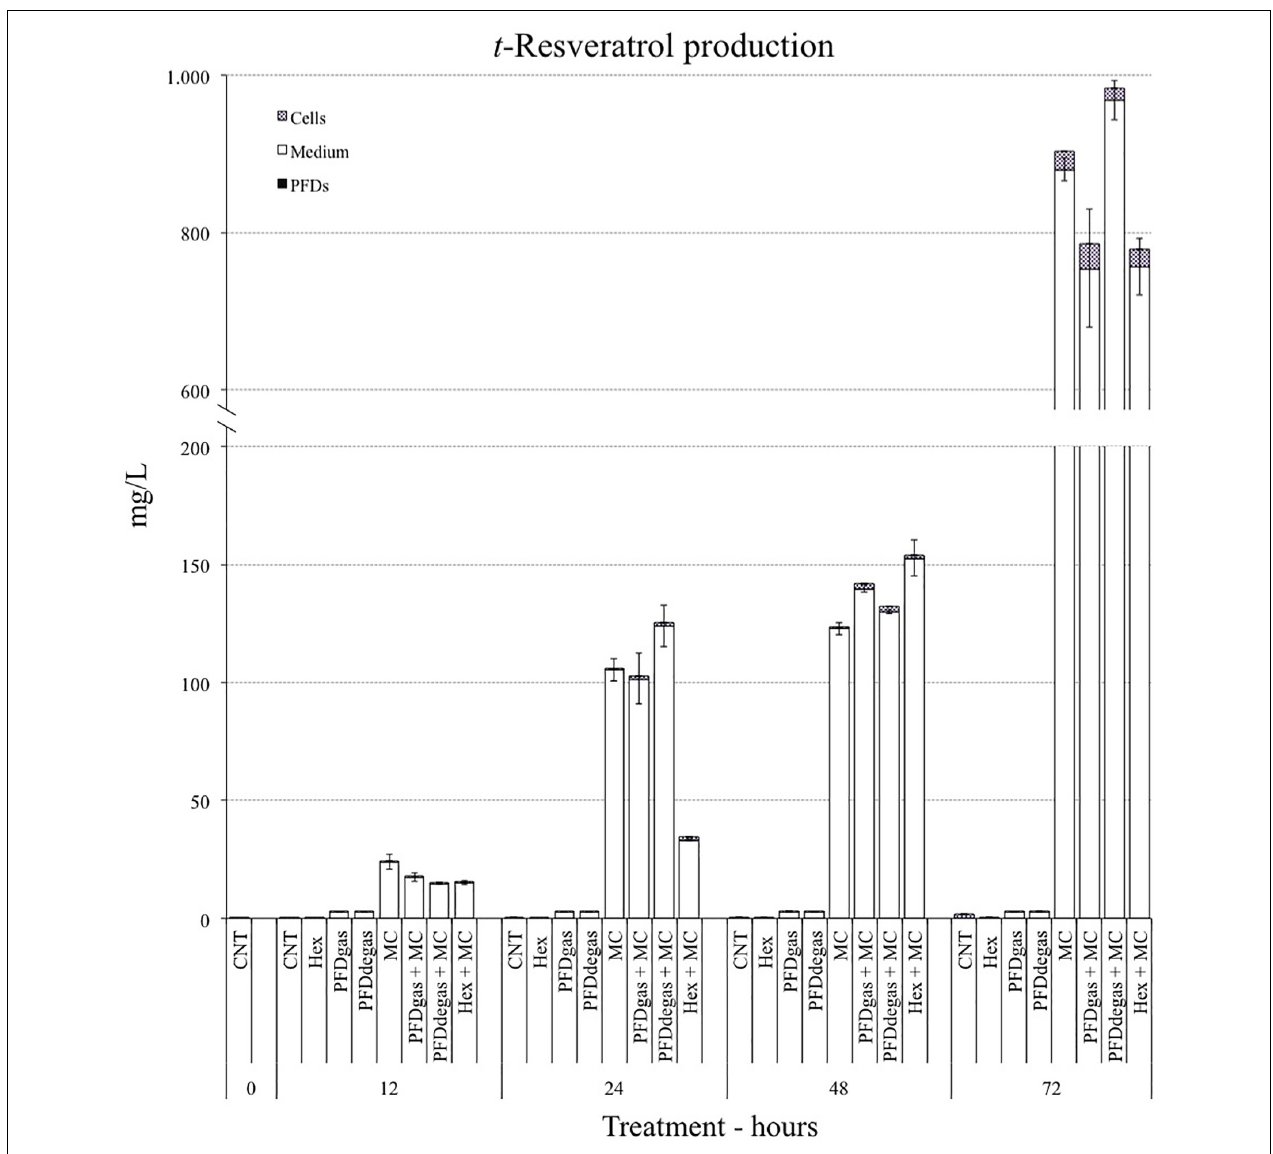
FIGURE 4 | Total trans -resveratrol accumulated inside the cells, culture medium and PFD phase at 72 h of the V. vinifera cell cultures. CNT, control; PDFgas, gassed perfluorodecalins; PFDdegas, degassed perfluorodecalins; PDFgas + MC, gassed perfluorodecalins plus MeJA and β -CDs; PDFdegas + MC, degassed perfluorodecalins plus MeJA and β -CDs; Hex, Hexenol; Hex + MC, Hexenol + MeJA+ β -CDs; MC, MeJA and β -CDs. Data are the mean of three independent replicates ± SD.